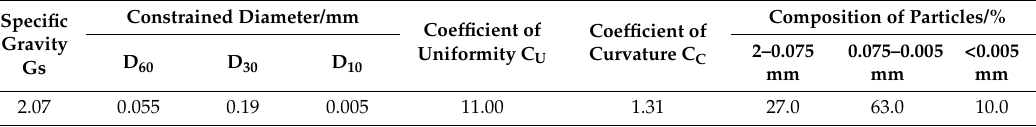
Table 2. The physical property indices of